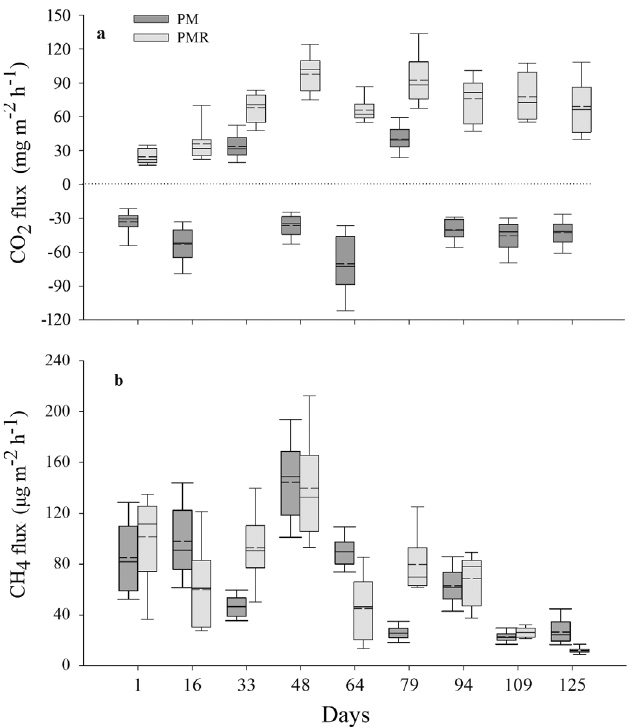
Fig. 2. Variations in (a) CO 2 and (b) CH 4 fluxes of the PM and PMR aquaculture systems (defined in Table 1) during the farming season. Boxes define the 25 th and 75 th percentiles, whiskers define the 5 th and 95 th percentiles, and solid and dashed horizontal lines show the median and mean values,